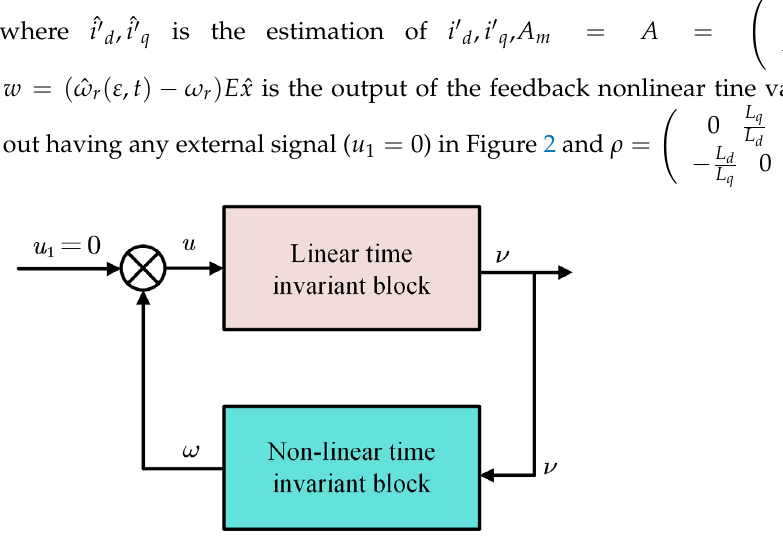
Figure 2. Block diagram of nonlinear time varying feedback system.